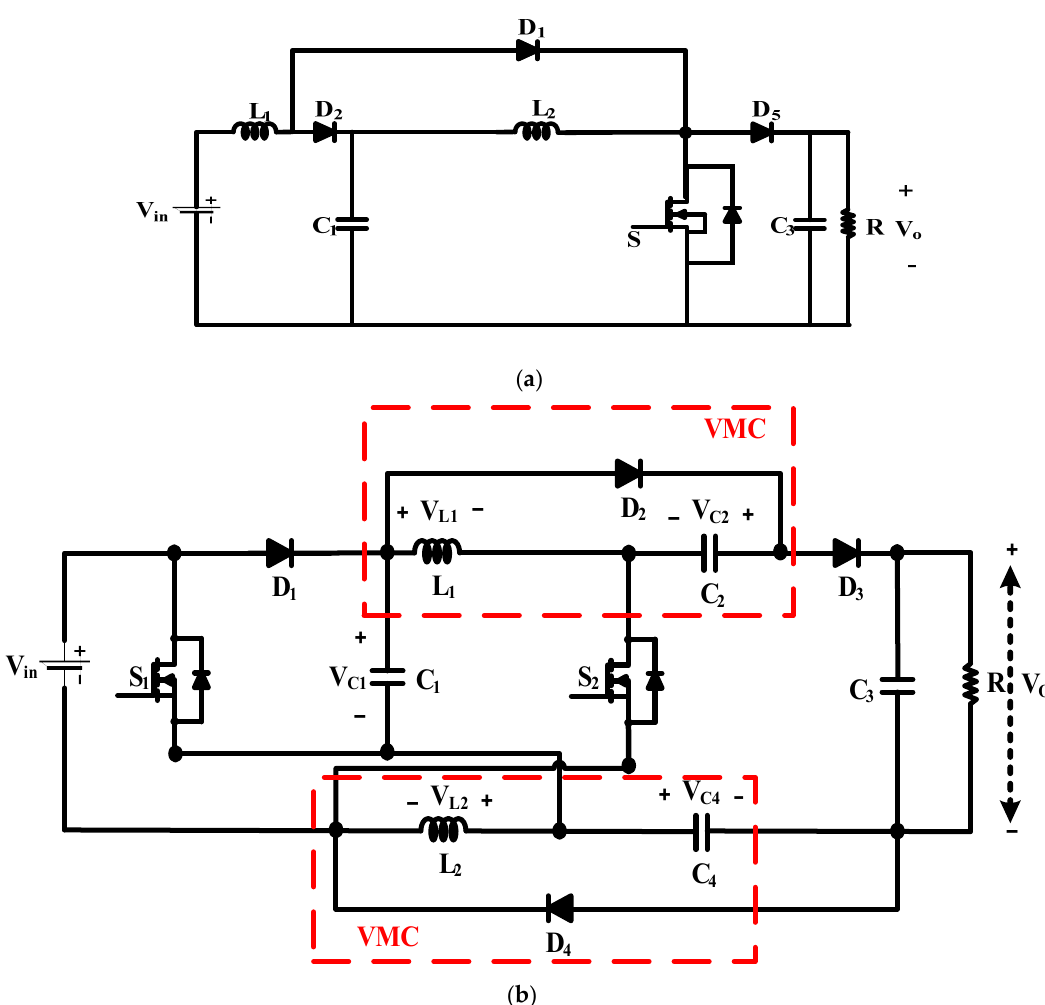
Figure 1. ( a ) Conventional quadratic boost converter (CQBC); ( b ). Proposed converter.